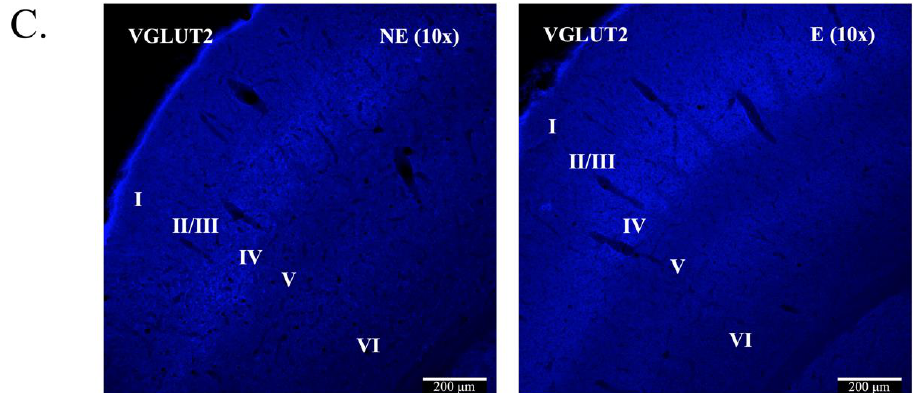
Figure 1. Representative confocal immunofluorescence images demonstrating expression of GABA A R α 1 in the stargazer primary SoCx. 10 × (Objective: 10 × Plan) magnification from control (NE) littermate and epileptic (E) stargazer are shown here . ( A ) Pseudo-green channel shows diffuse labelling for GABA A R α1 subunit across the cortical layers with higher intensity in layer IV. ( B ) Pseudo-red channel shows labelling for PV + neurons. The soma of PV + neurons are present in all layers except layer I. ( C ) Pseudo-blue channel shows VGlut2 which assists in identification of the cortical layers. Intense labelling can be seen, predominantly, in layer IV due to the presence of thalamocortical excitatory nerve terminals.